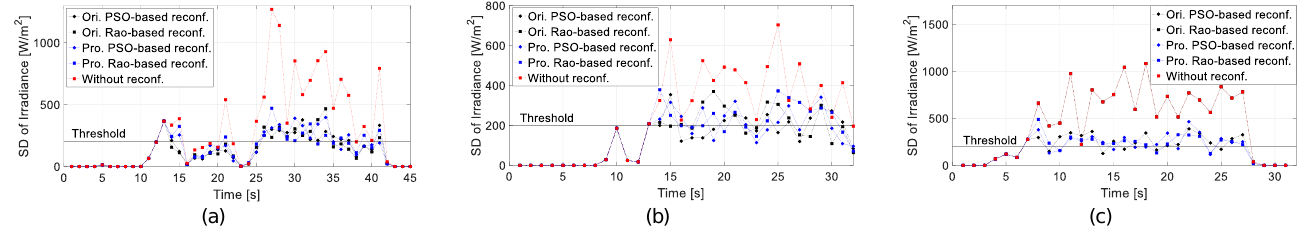
Figure 25. Comparison of SDI of TCT-configured, original-PSO-reconfigured, original-Rao-reconfigured, proposed-PSO-reconfigured, and proposed-Rao-reconfigured PV arrays under three shading cases with lagged time. ( a ) Case 1. ( b ) Case 2. ( c ) Case 3.